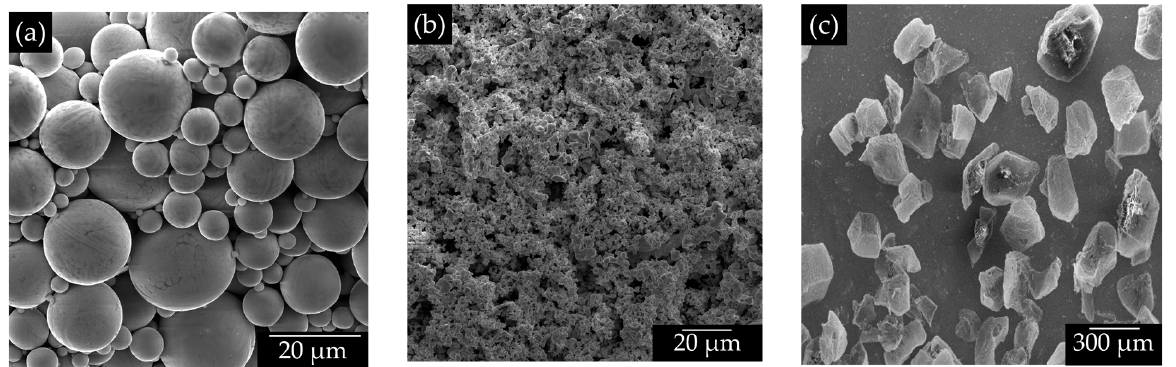
Figure 1. Micrographs of the used powders; ( a ) Ti; ( b ) Ta; and ( c ) ((NH 4 ) HCO 3